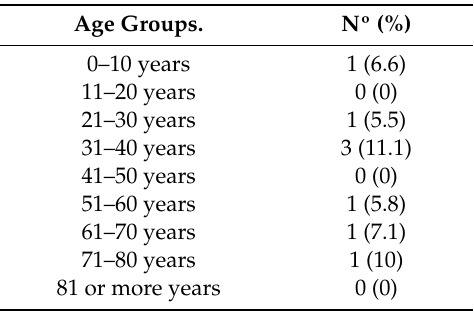
Table 2. Seroprevalence with respect to